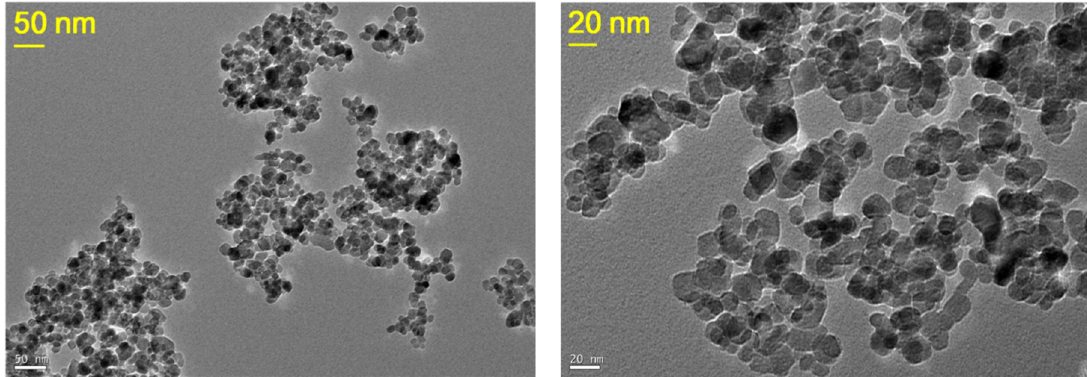
Figure 2. TEM images of magnetic Fe 3 O 4 nanoparticles.